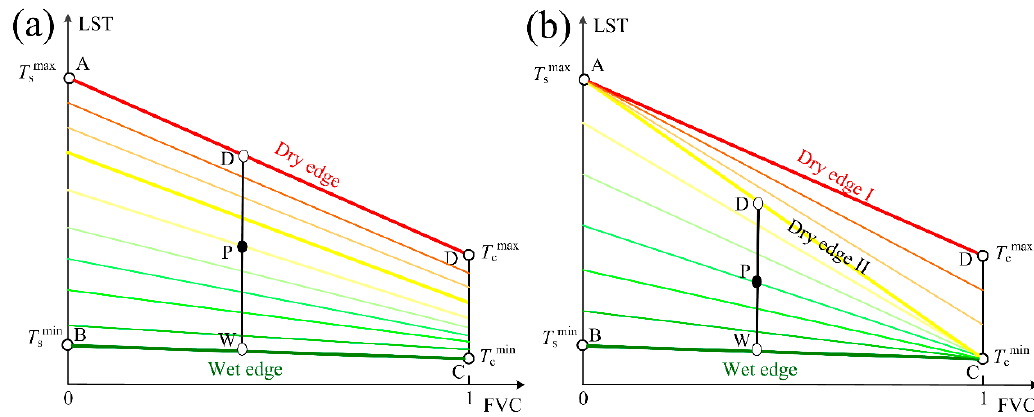
Figure 4. Two interpretations of the LST/FVC space: ( a ) conventional trapezoid and ( b ) two-stage trapezoid. Points A and D represent the soil and vegetation components under the maximum water stress with values of T max s and T max c . Points B and C represent the soil and vegetation components under saturated water supply with values of T min s and T min c . P is any given point. Points W and D represent LSTs on the wet and dry edges having the same FVC with point P.